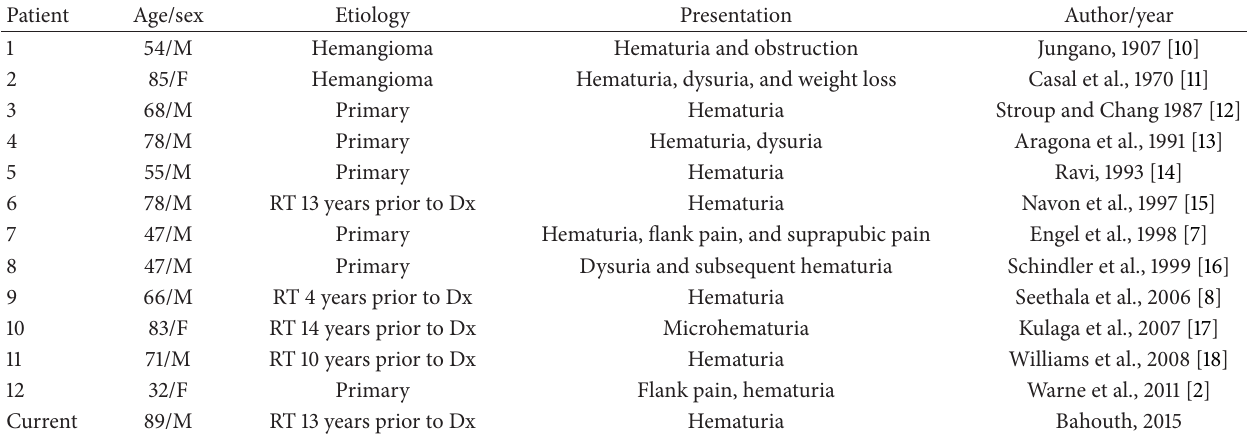
Table 1: All reported patients’ characteristics.